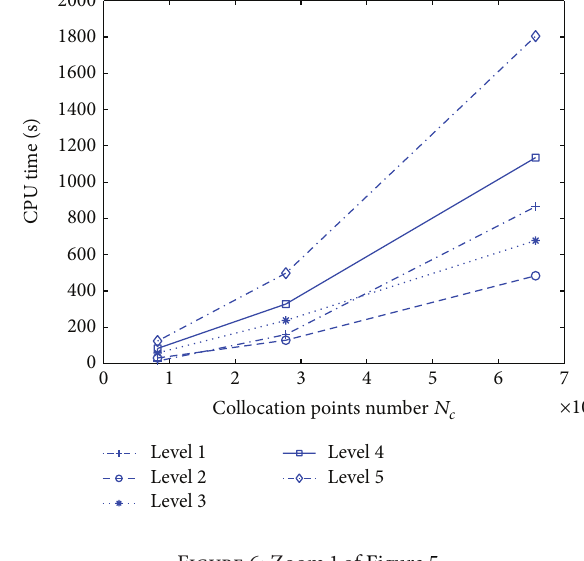
Figure 6: Zoom 1 of Figure 5.